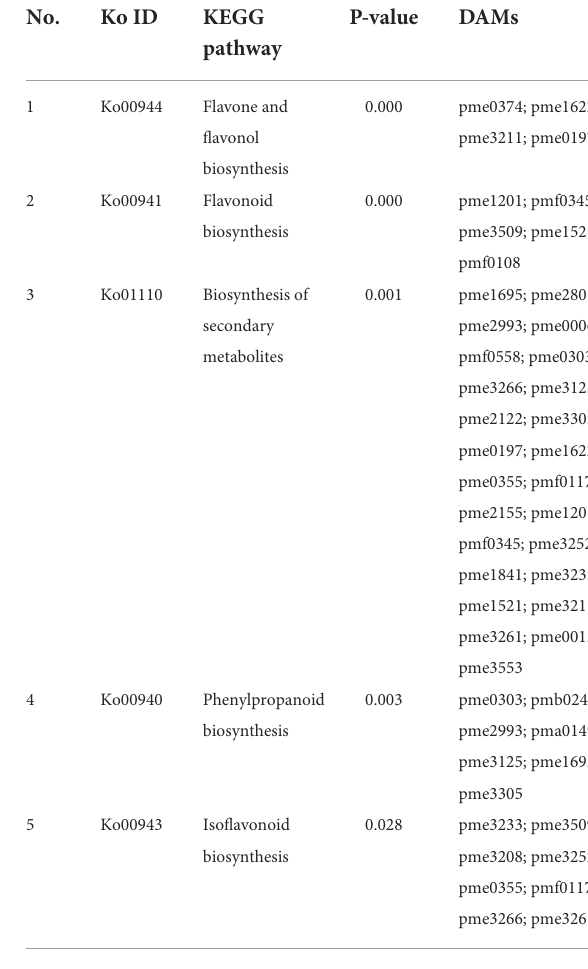
TABLE 3 The enriched pathways of differentially altered metabolites (DAMs) compared 3d + S-0h vs. 3d + S-24h in KEGG analysis. No.